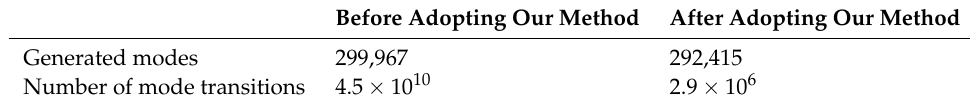
Table 3. Comparison among the various parameters obtained by Example